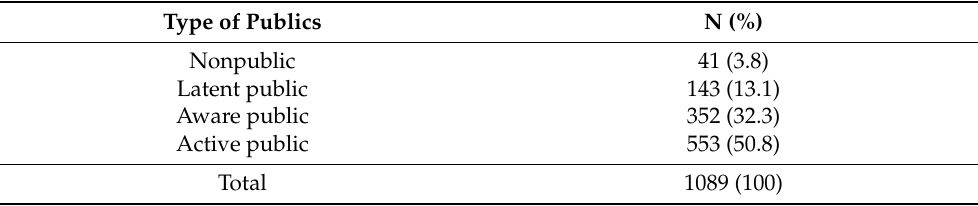
Table 2. Four types of publics in China about the issue of GM